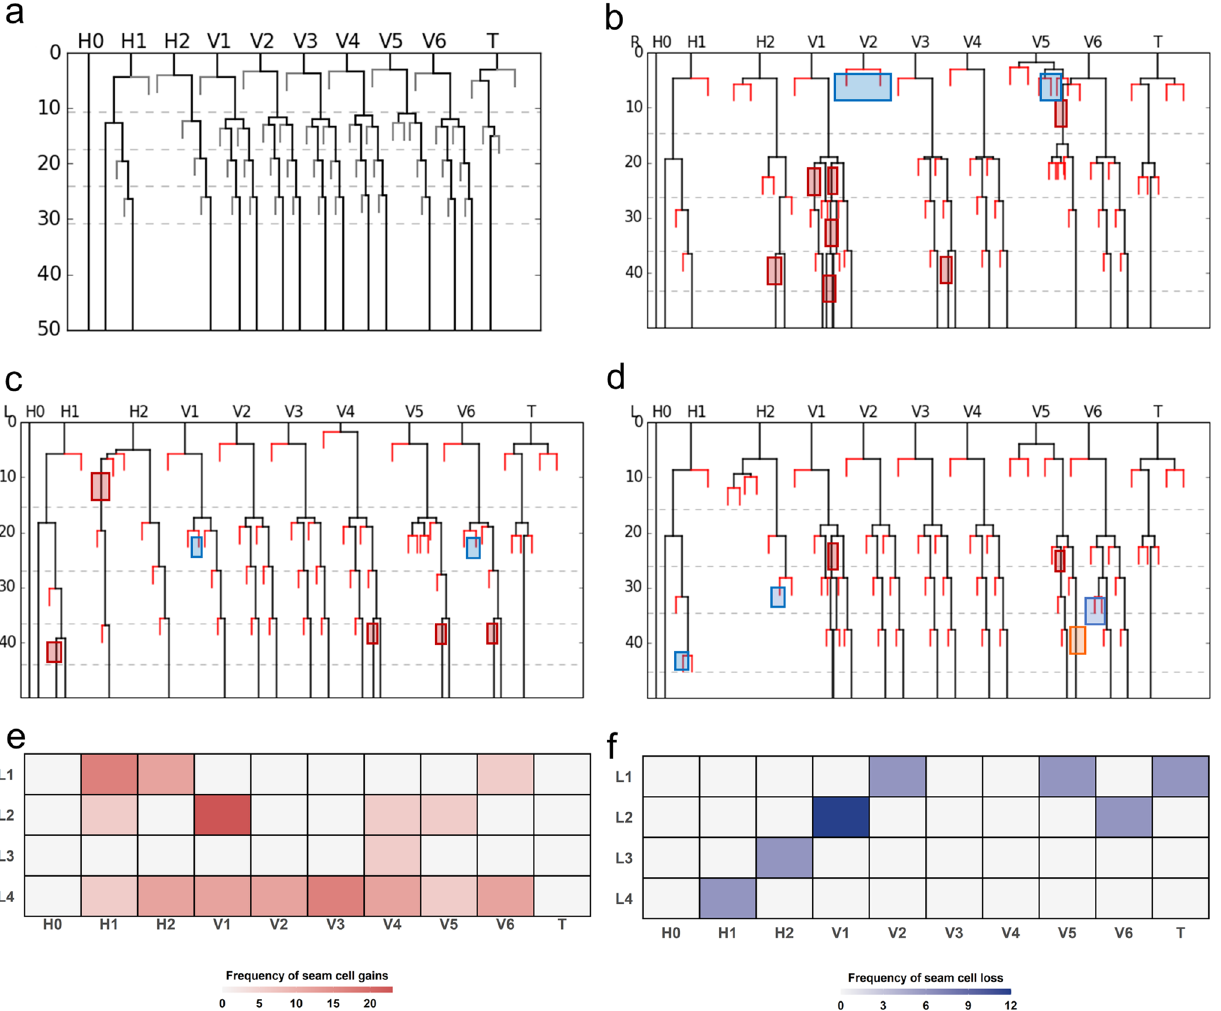
Figure 5. Developmental basis of seam cell number variability in eff-1(icb4) . ( a–d ) Representative seam cell lineages of wild-type ( a ) and eff-1(icb4) animals ( b – d ). The coloured boxes in ( b–d ) highlight developmental errors. Red boxes mark gains of seam cells, blue boxes loss of seam cells. Note that the animals in ( b–d ) show a terminal SCN of 19, 18 and 16 seam cells respectively. ( e ) Summary heat map of lineage errors observed which increase seam cell number. ( f ) Summary heat map of lineage errors which decrease seam cell number. Numbers in e and f represent percentage of the error in the 18 lineages analysed. Note that the percentage of symmetrisation errors towards the seam cell fate is highest at the L4 stage. Panels a-d were created using a lineaging visualisation pipeline described in 28 and panels e–f using R version 4.0.3 45